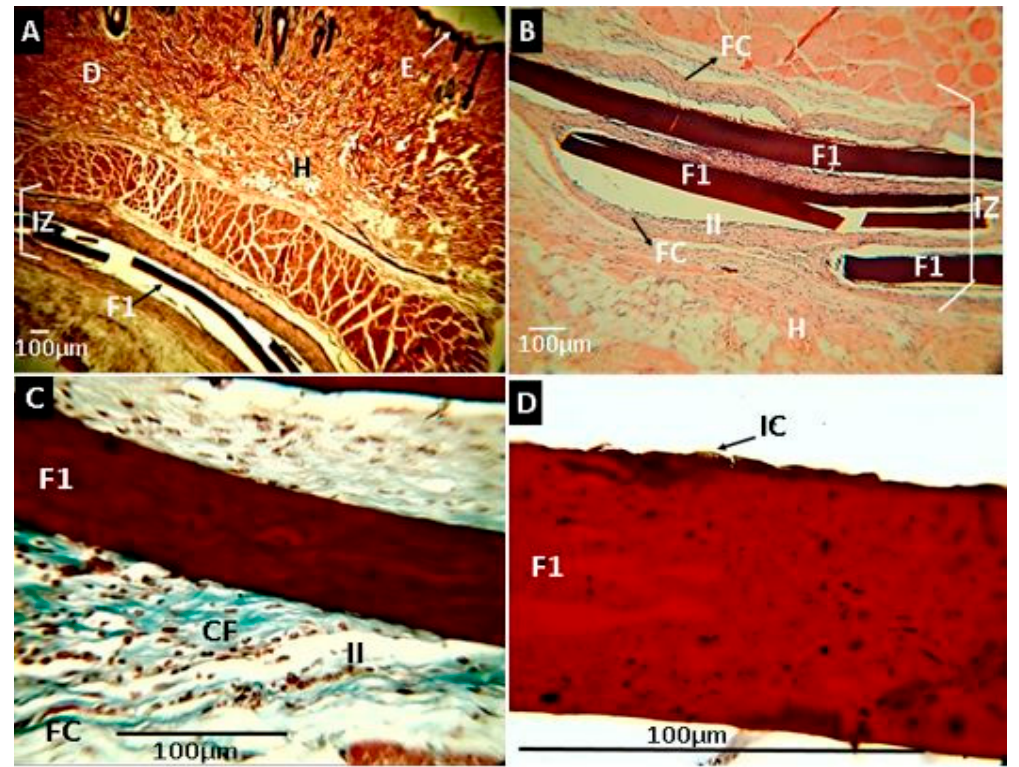
Figure 11. Histological analysis of experimental sample F1 (CS: PVA:ox-CNO